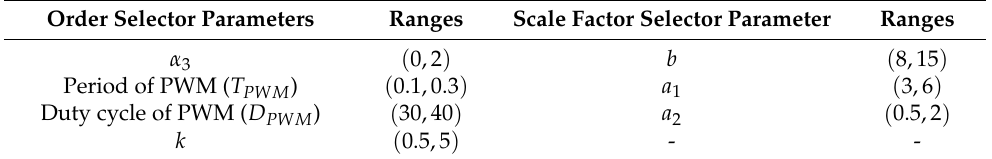
Table 4. Constraints for NSGA-II.